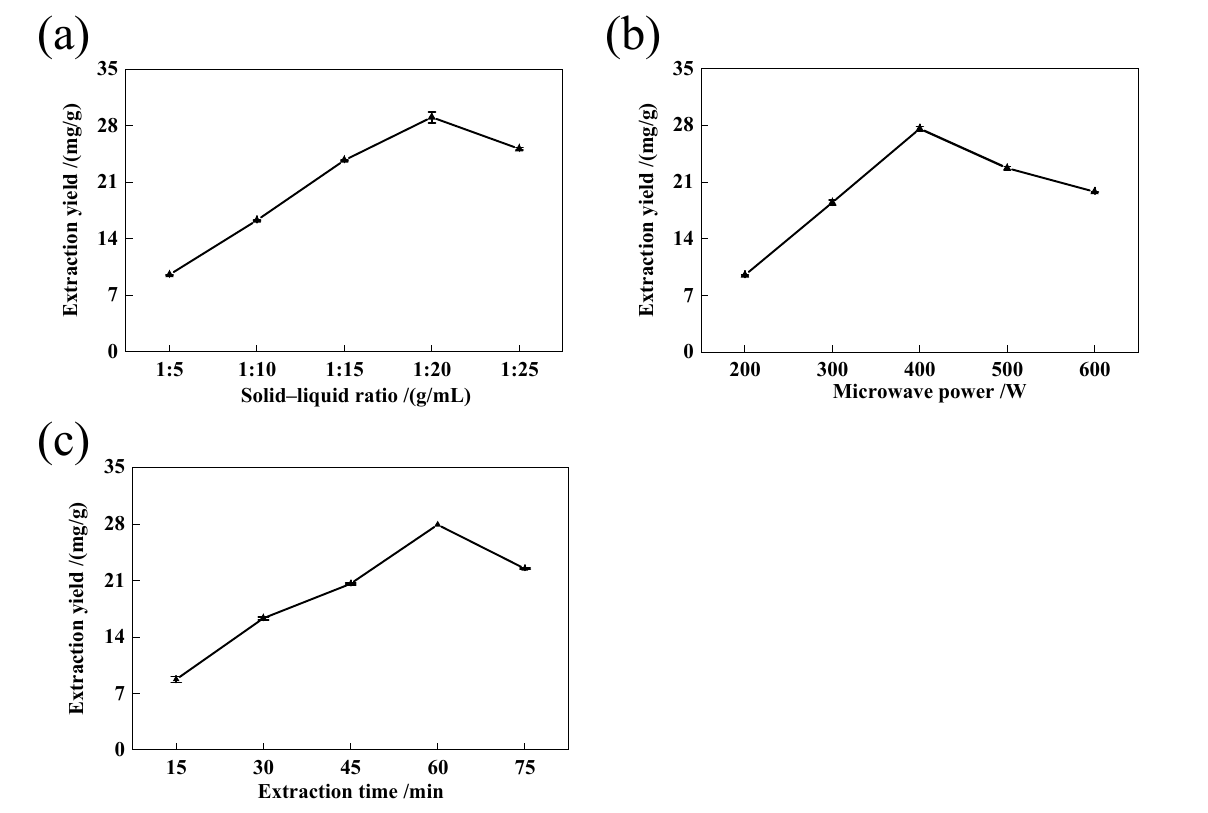
Figure 1. The effects of the solid–liquid ratio ( a ), microwave power ( b ) and extraction time ( c ) on TTC extraction from LIM leaves.